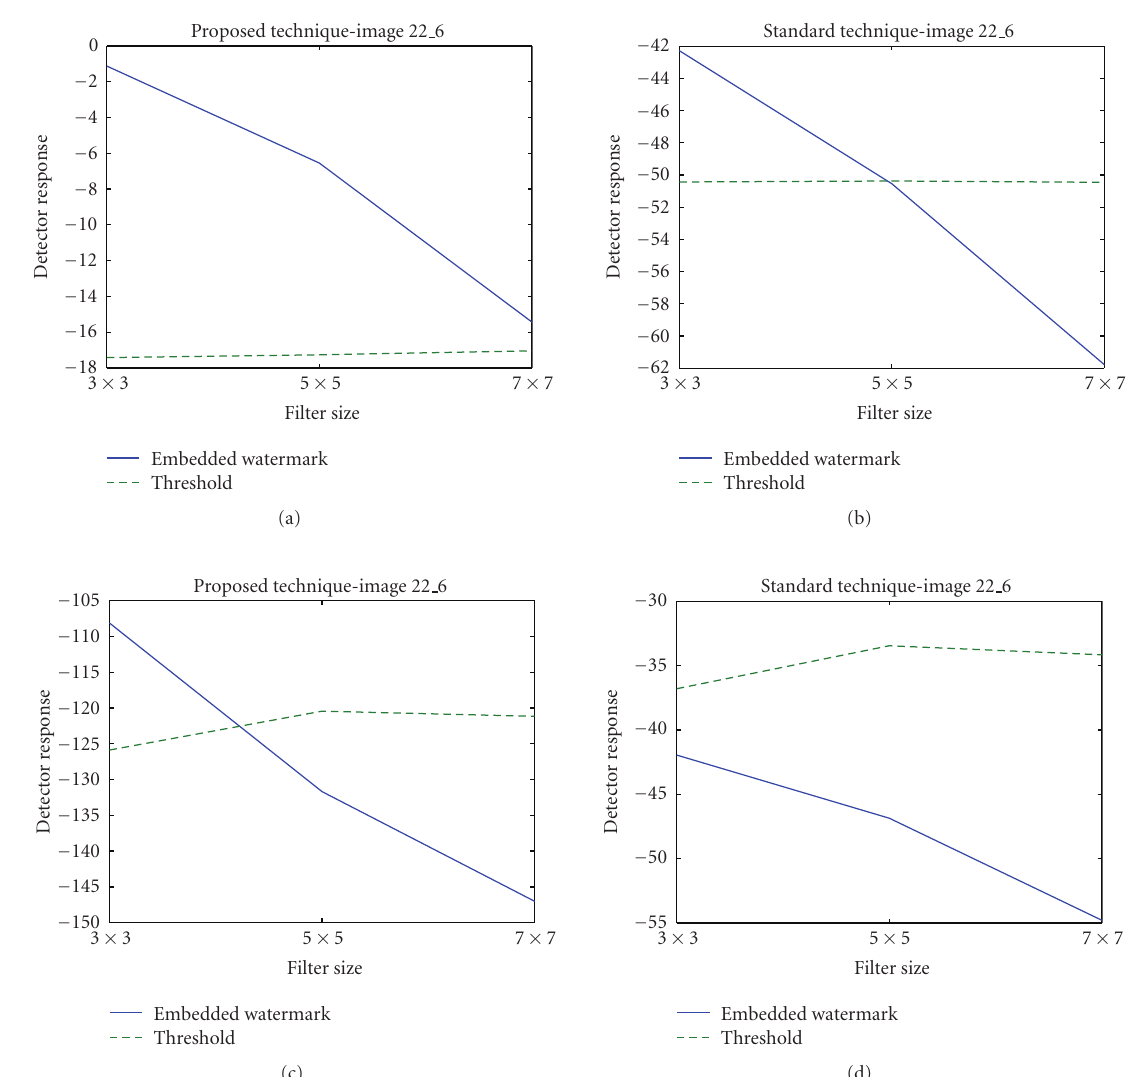
Figure 13: Robustness against mean filtering. Top: DWT domain. Bottom: DFT domain. Left side graphs: Proposed technique. Right side graphs: Standard